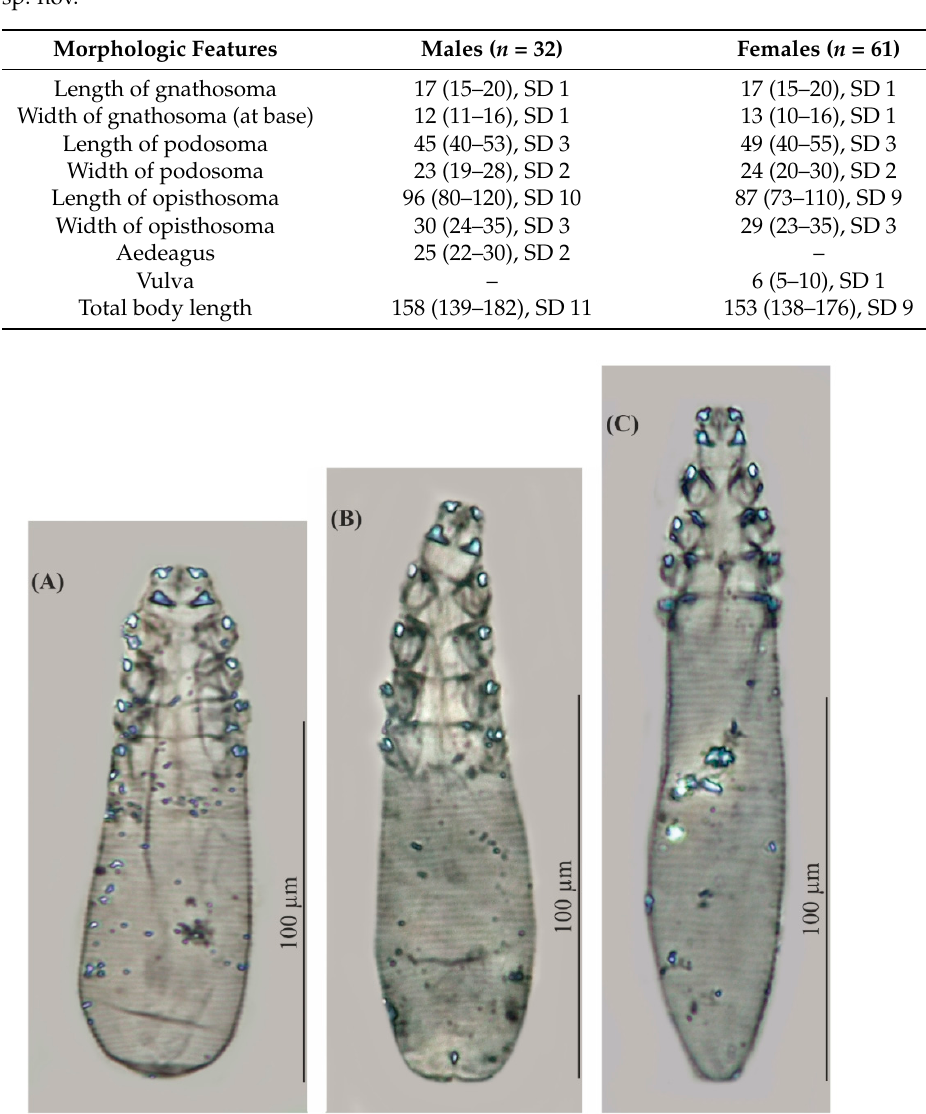
Figure 2. Demodex talpae , female ( A ) and Demodex crocidurae sp. nov., female, holotype ( B ), male ( C ). Infection and location in the host. Demodex crocidurae sp. nov. was found in all exam- ined lesser white-toothed shrews (100%), with a mean intensity of 11.7 and intensity range of 3–26 individuals per host: 93 individuals in total (32 males, 61 females). The demodecid mites were found on the hairy skin of the body (head—31 individuals, abdomen—30, back—28, and genital-anal area—4). The observed mites did not cause any lesions in ex- amined